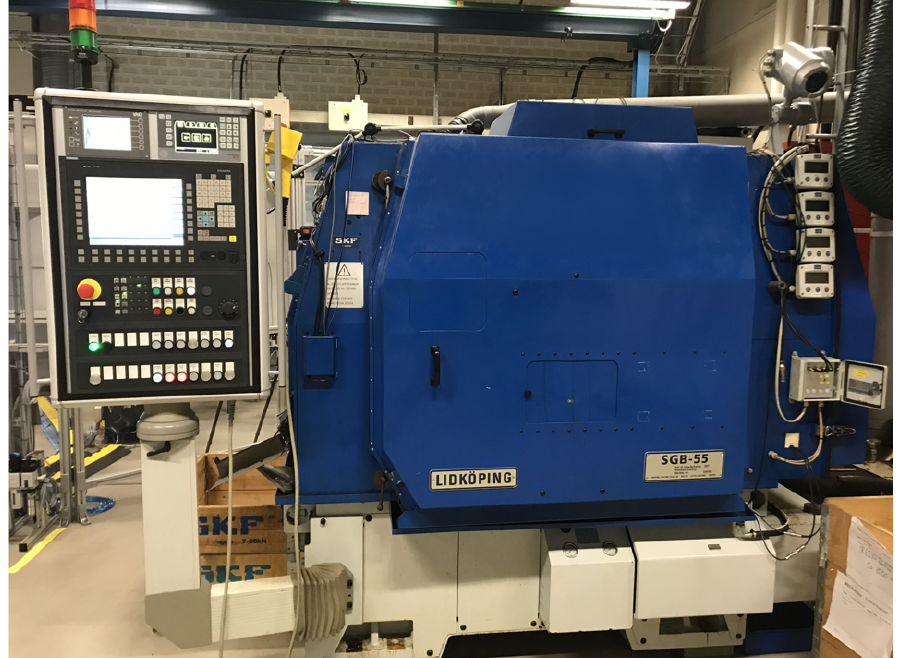
Figure 1. The Lidköping SGB55 bearing ring grinder used in this investigation.